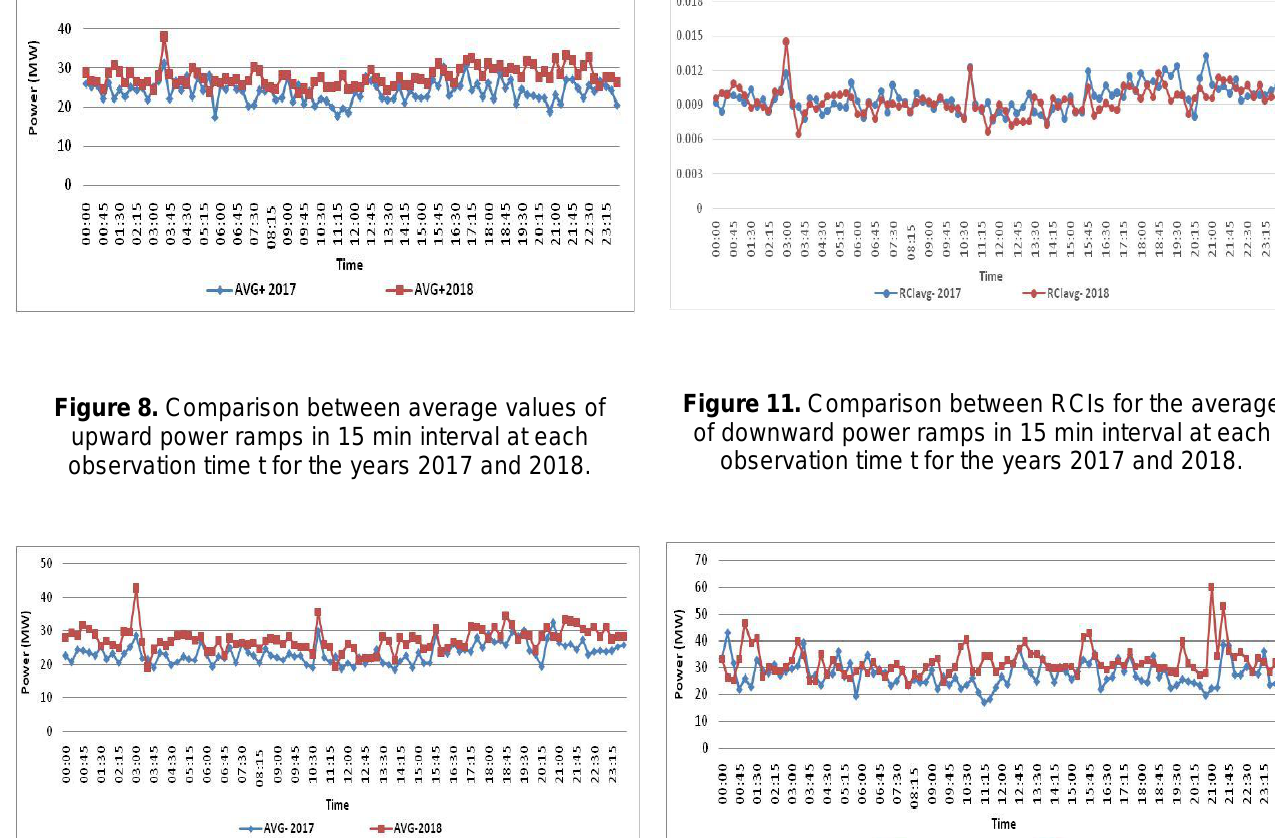
Figure 12. Comparison between standard deviation values of upward power ramps in 15 min interval at each observation time t for the years 2017 and